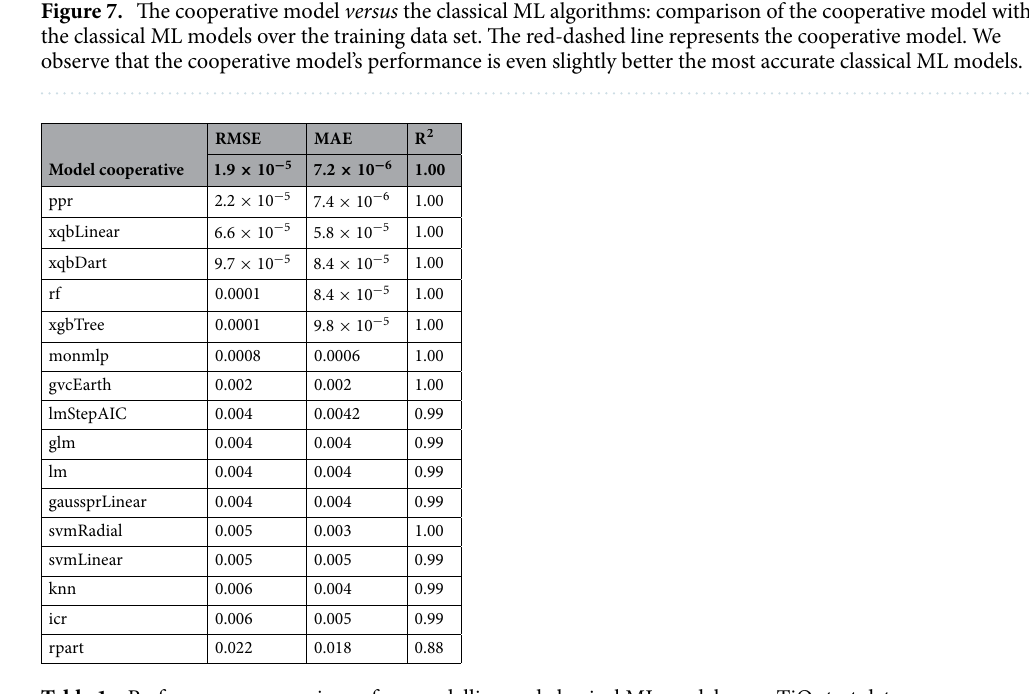
Table 1. Performance comparison of co-modelling and classical ML models over TiO 2 test